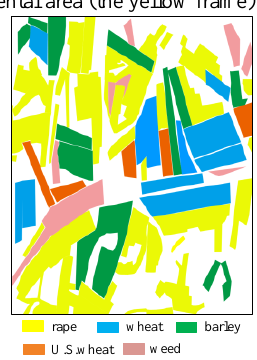
Figure 1 . Radarsat-2 images of Gen River: (a) Pauli synthetic images, (b) Experimental area (the yellow frame)